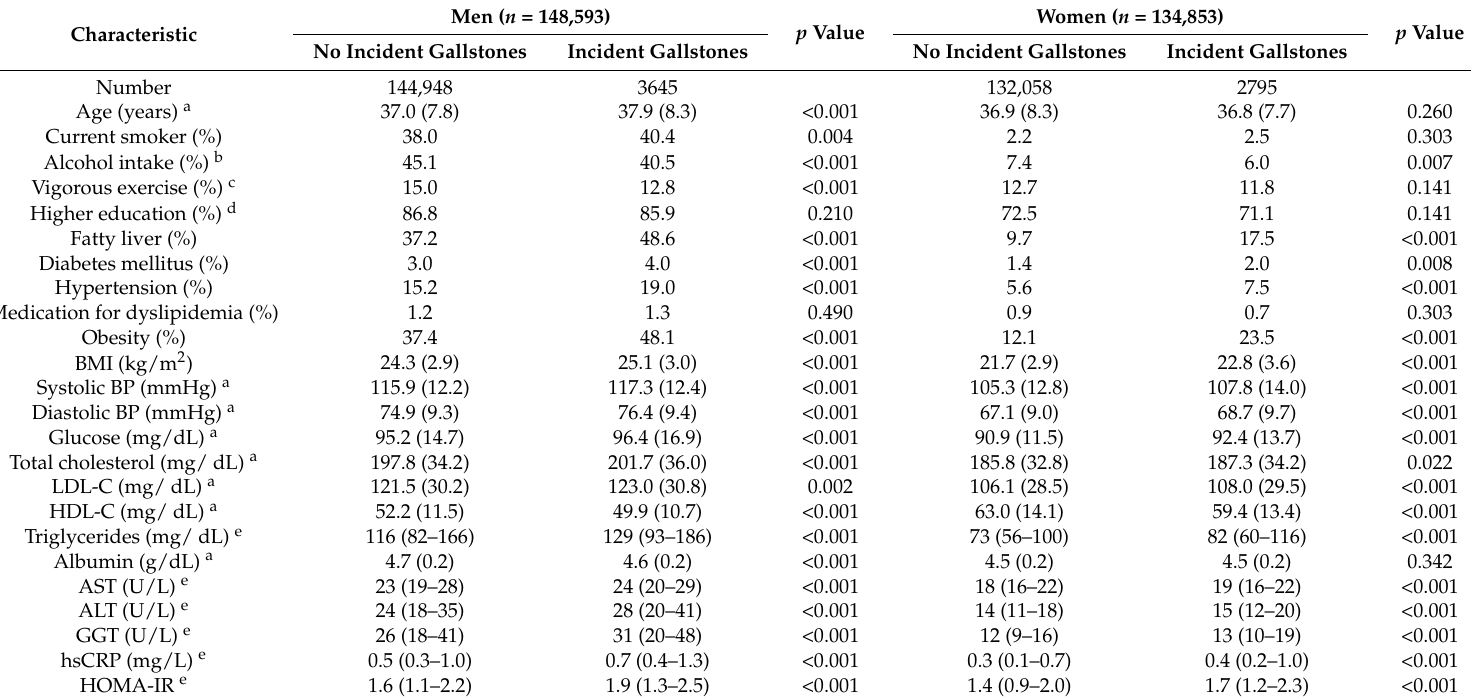
Table 1. Baseline characteristics of study participants according to incident gallstones by sex ( n =